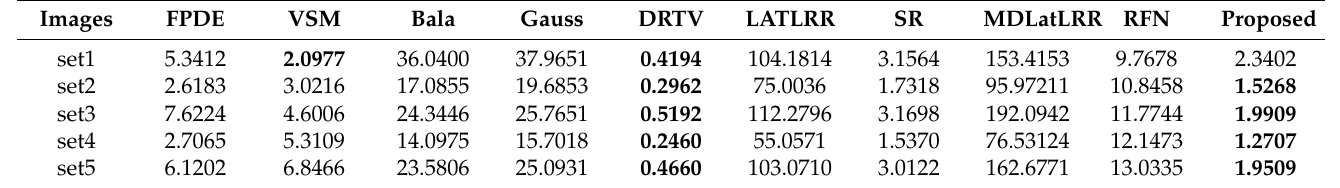
Table 4. Running time T (s) of the ten methods on the RoadScene Table 3. Running time T (s) of the ten methods on the TNO dataset.